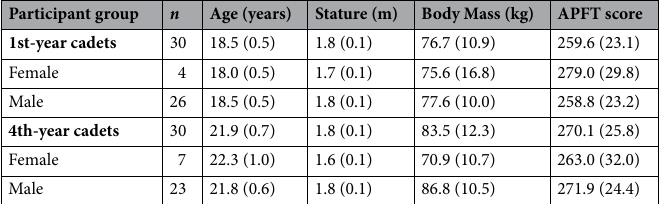
Table 1. Demographic and anthropometric data. All values reported as means